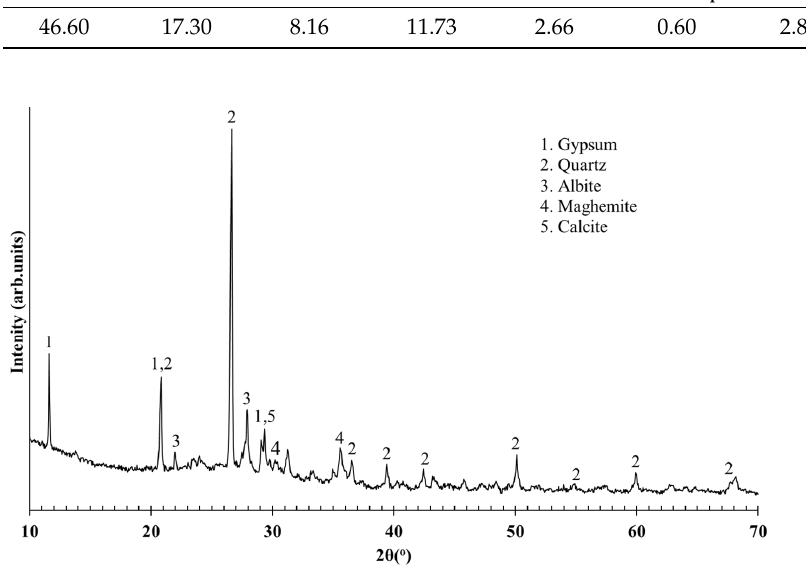
Figure 1. Powder X-ray diffraction patterns of fly ash.